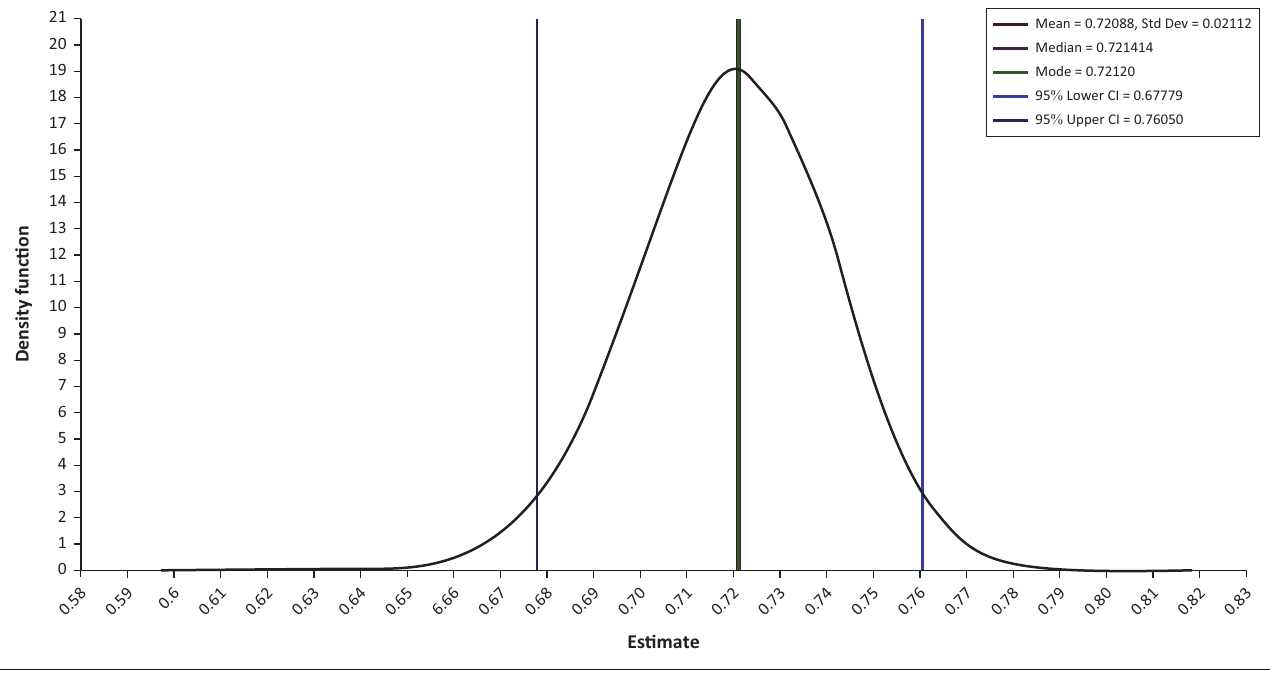
FIGURE 3: The density function and parameter loading for item p1 on the 1-factor (Fact) model (use colour in